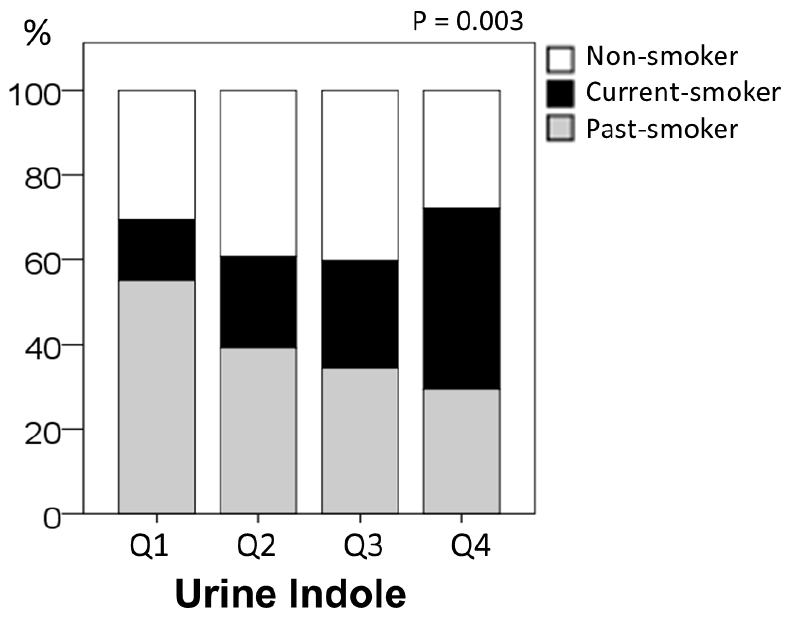
Figure 1. The ratio of smoking status in the quartile groups by urine indole concentration level. The p -value on the graph stands for the statistical significance of difference in the proportion of the three smoking groups among the quartile groups ( p = 0.003).